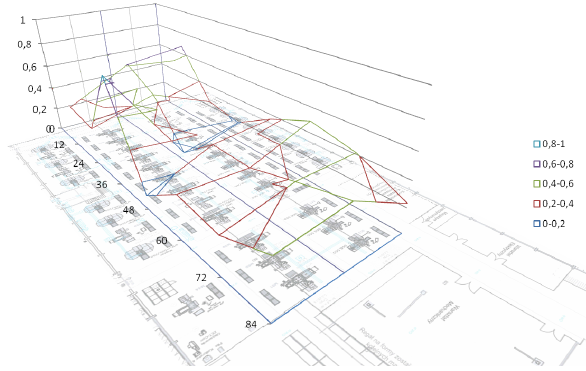
Figure 4: Air temperature in Hall1 at a height of 4 m, °C.